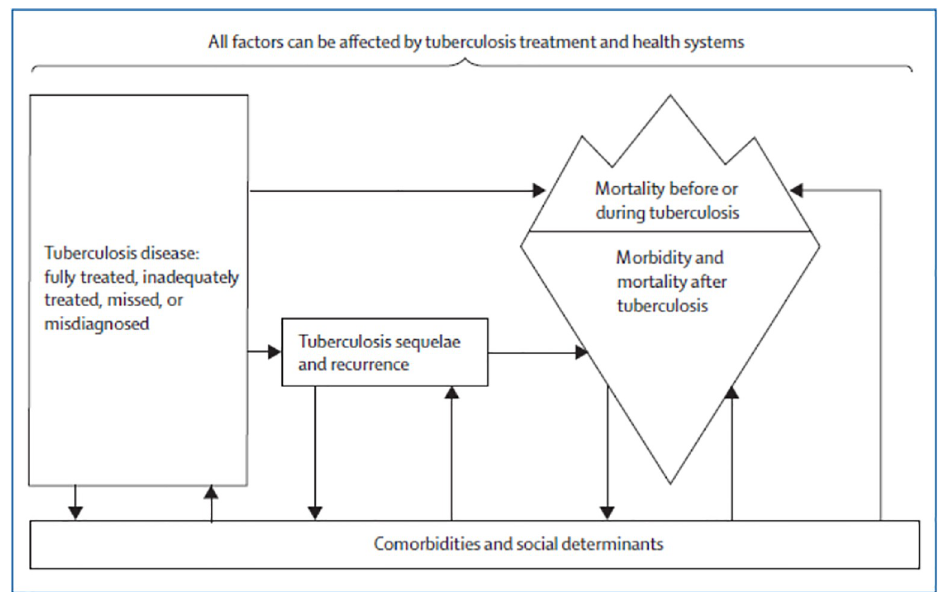
Fig 1. Biological framework for understanding post-TB treatment morbidity and mortality developed by Datta and Evans [24].